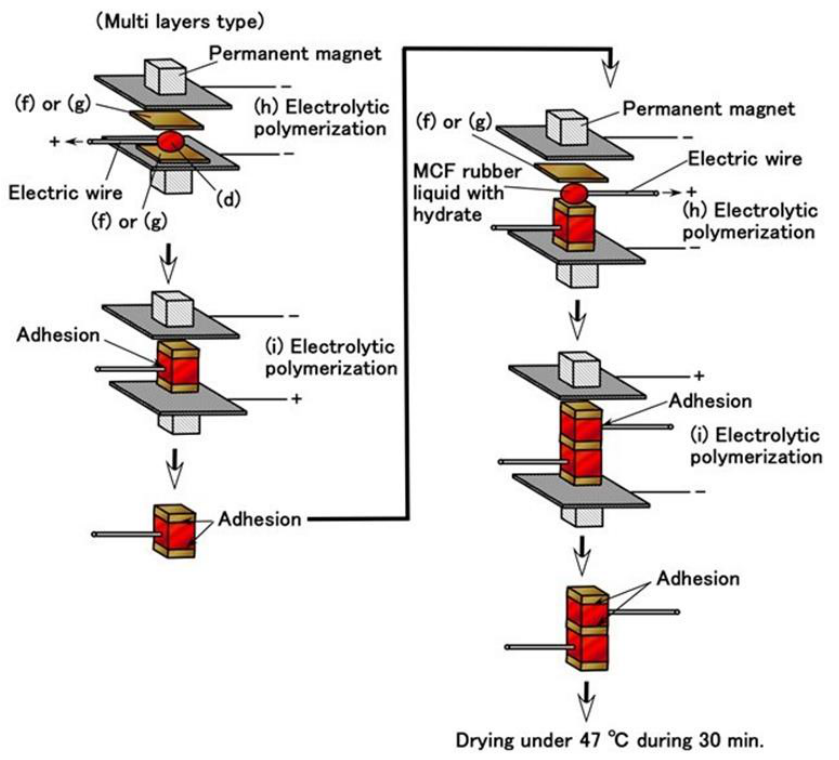
Figure 9. Procedure for the production of MCF rubber sensor with multi layers.